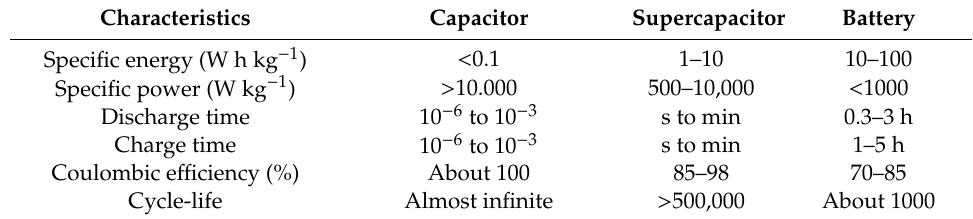
Table 3. Characteristics of selected electrochemical energy storage technologies.